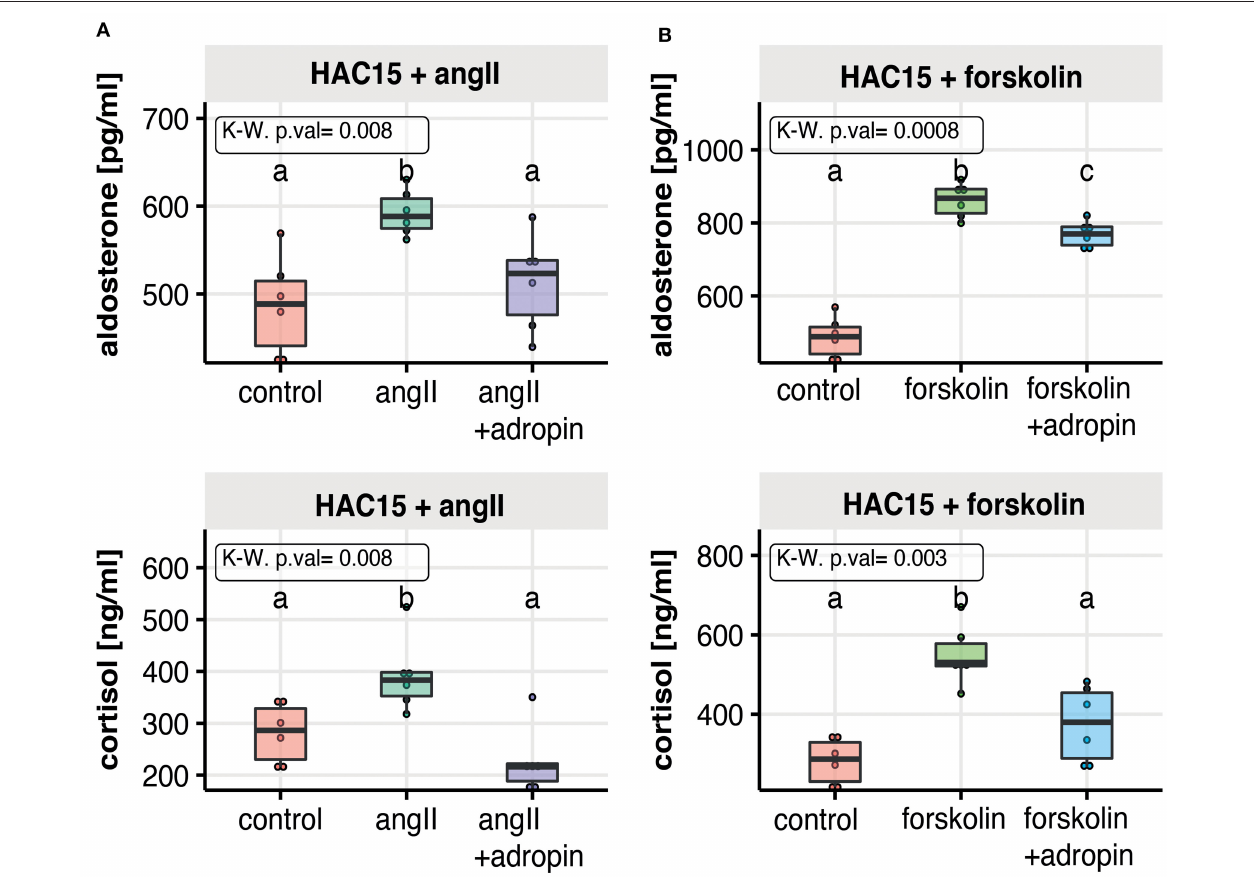
FIGURE 3 | The effect of adropin on angII (A) or forskolin (B) stimulated aldosterone and cortisol secretion in the human adrenal carcinoma (HAC15) cell line exposed to adropin for 24h. Results are presented as medians with IQR. Statistical differences were determined by Kruskal–Wallis test followed by Dunn’s post hoc test. Groups sharing the same letter are not significantly different according to Dunn’s